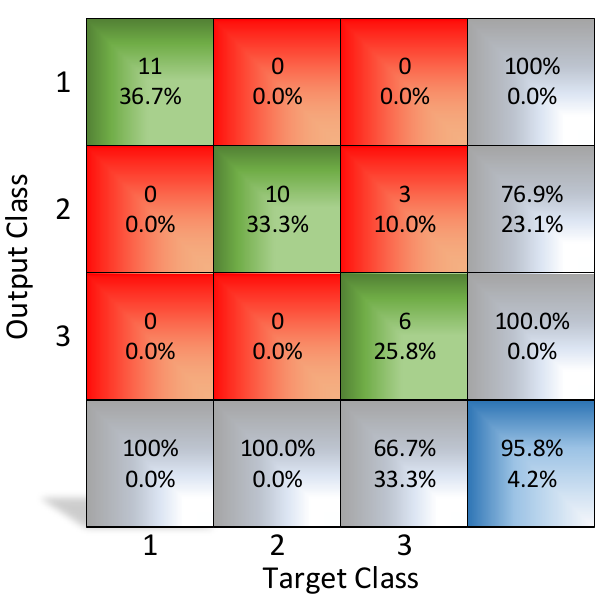
Figure 13. Matrix of the obtained results using MATLAB (11 × 11 pixels resolution).